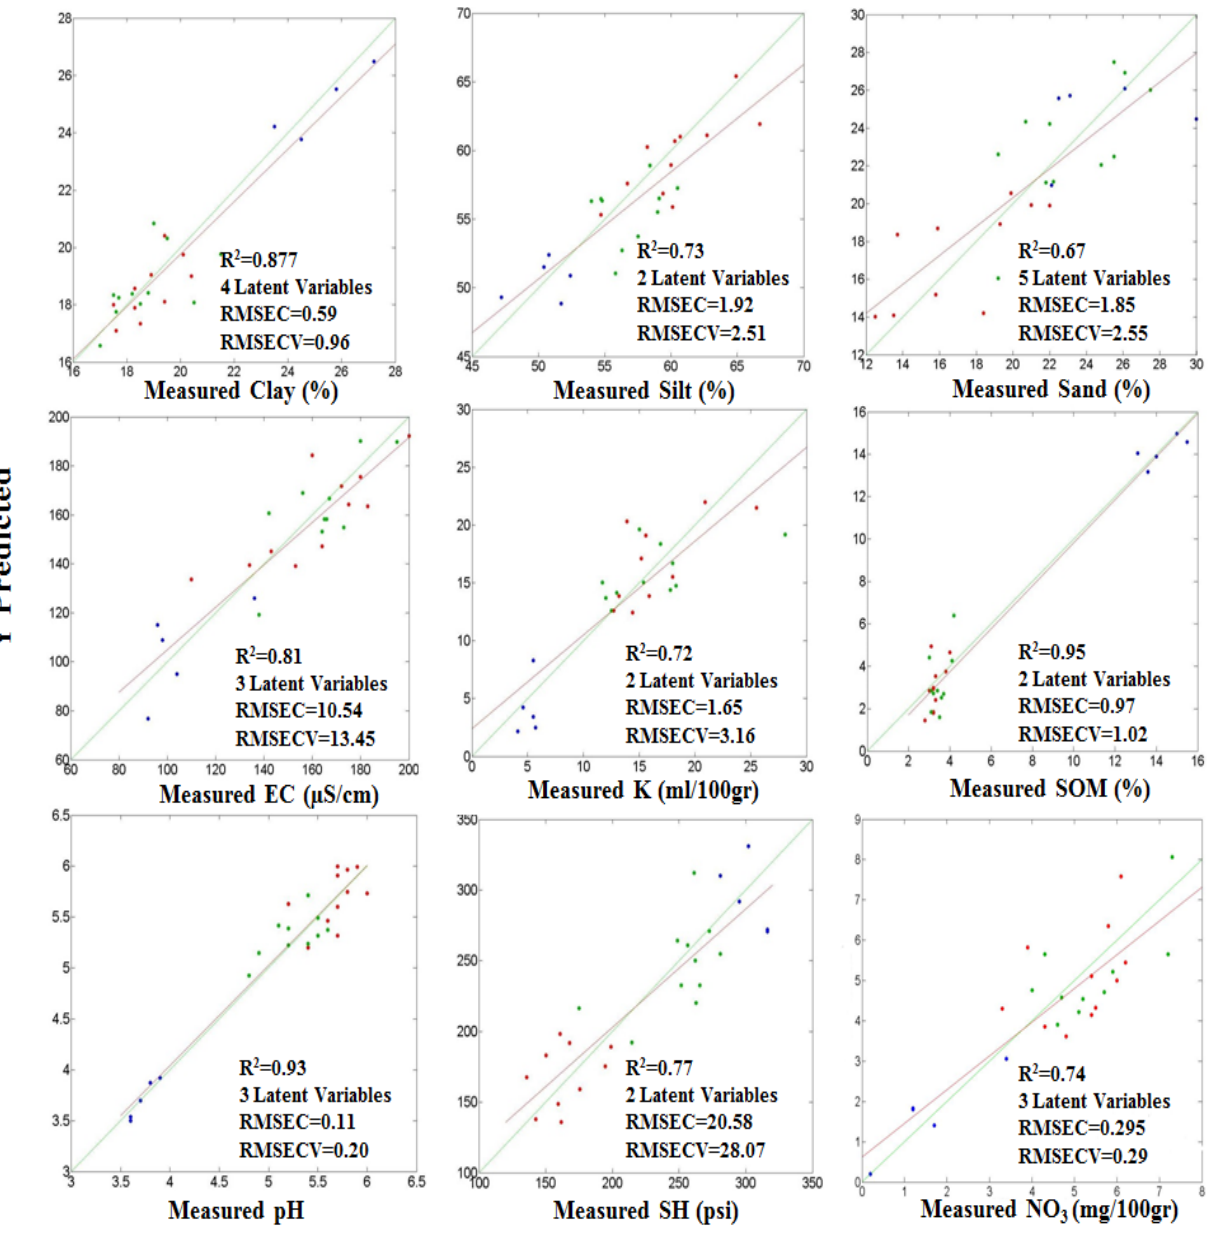
Figure 7. Scatterplots of cross-validation (CV) predicted values versus measured values for several soil properties for the calibration dataset for all land uses in the Schäfertal site, Germany. Calibration models were developed with a partial least squares-regression (PLS-R). RMSEC: root mean square error of calibration; RMSECV: root mean square error of cross-validation; EC: electric conductivity; K: potassium; NO 3 : nitrate; SOM: soil organic matter; SH: surface hardness. The colors of the spots represent land-use types: forest (blue), fertilized agricultural field (red), unfertilized agricultural field